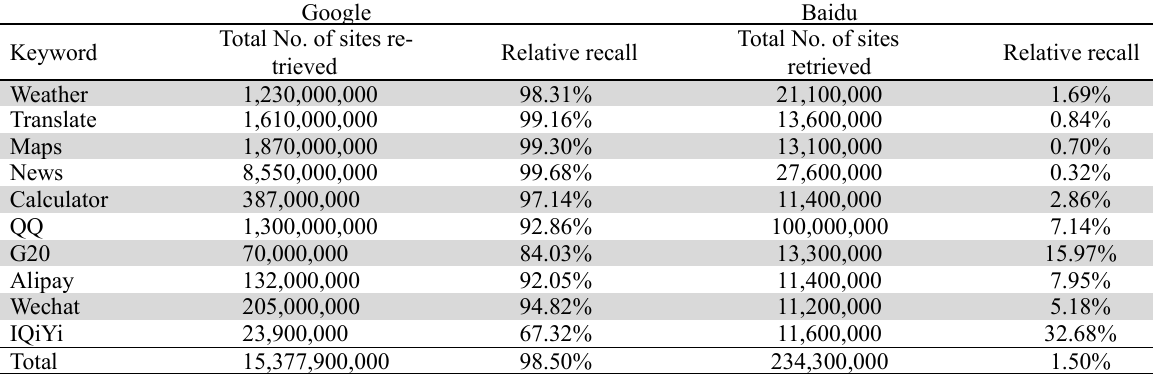
Relative Recall of